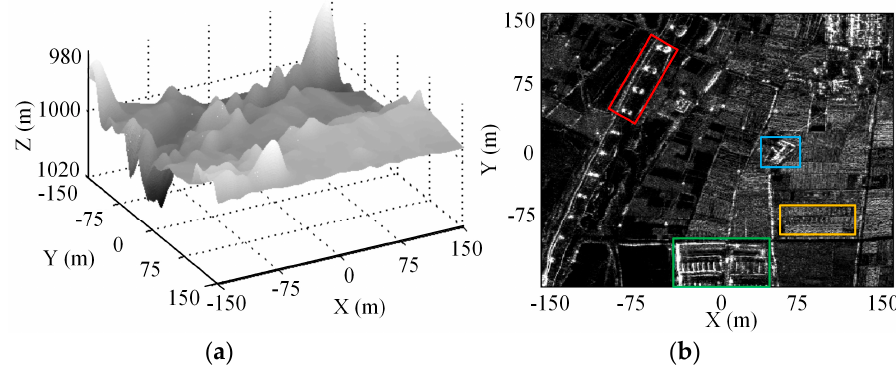
Figure 7. 3-D imaging scene simulation. ( a ) Airborne DEM; ( b ) 2-D circular SAR image.